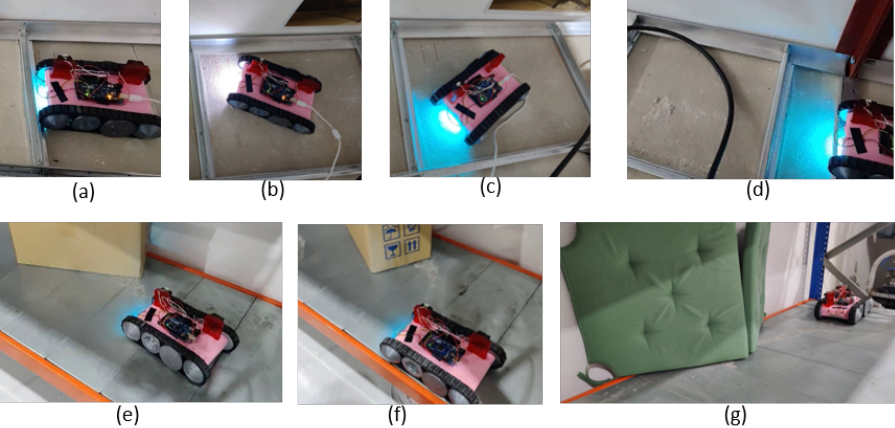
Figure 9. The arrangements of the test cases used in the second phase of the experiment. ( a ) The robot was placed with no heading error with the perimeter wall. ( b ) The robot was placed with an inward heading error. ( c ) The robot was placed with an outward heading error. ( d ) A segment with more objects to be traverse. ( e ) A segment with an inward slanting perimeter. ( f ) A segment with an outward slanting perimeter. ( g ) A segment with an inward and outward slanted